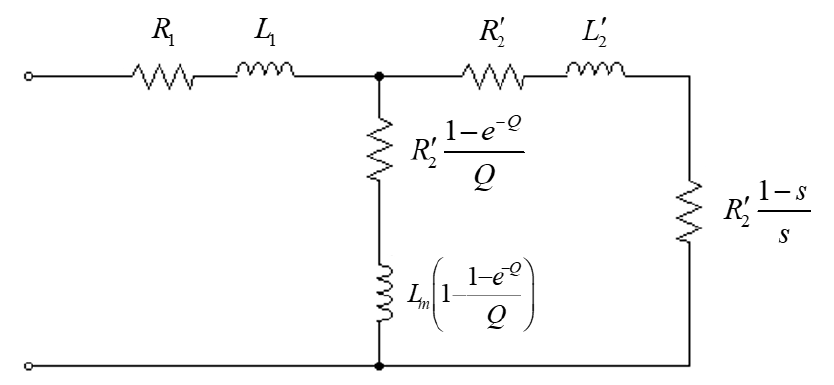
Figure 3. Resulting equivalent circuit according to